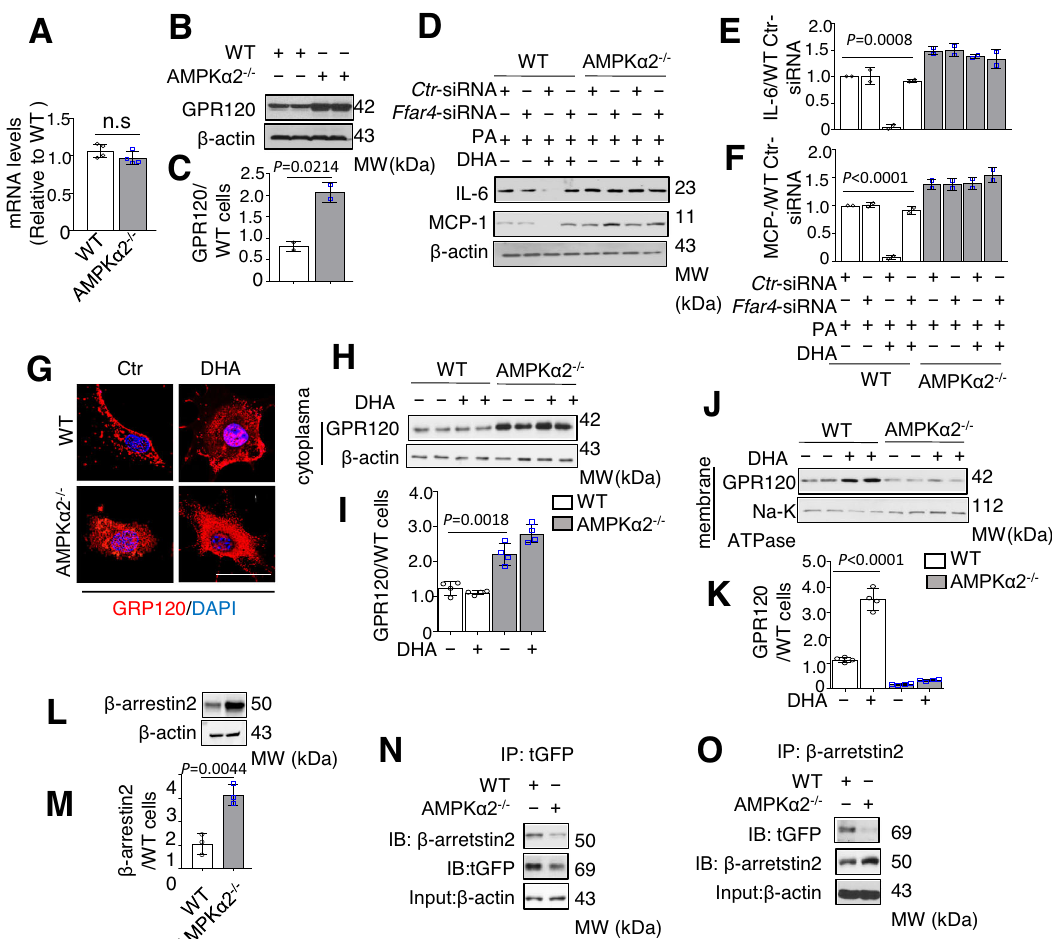
H – K Representative western blots ( H , J ) and quanti fi cation ( I , K ) of GPR120 expression in cytoplasmic and membrane fractions before and after a 1-h DHA treatment( n =4). L , M Westernblotandquanti fi cationof β -arrestin2expressionin WT and AMPK α 2 − / − VSMCs ( n =3). N , O IP assays for studying GPR120 – β -arrestin 2 interactions in WT and AMPK α 2 − / − VSMCs. All data shown represent one of two separateexperiments.Quanti fi cationofwesternblotswasperformedusingImage- Pro plus software, distinctly from loading controls. Data are presented as the mean±s.e.m. p valuebytwo-sidedStudent ’ s t tests. Ctr -siRNAcontrolsiRNA, Ffar4